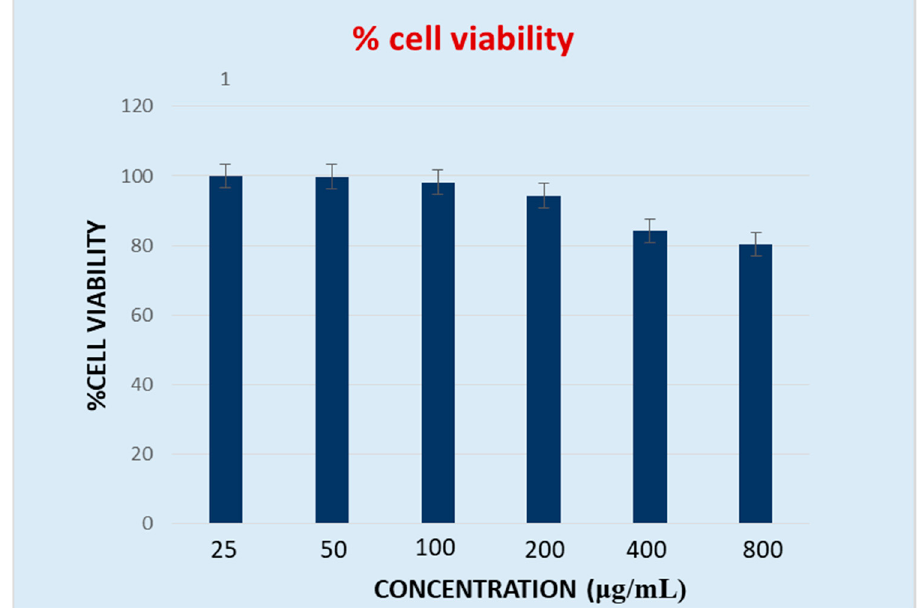
Figure 9. Effect of ethanol extract of C. papaya leaves on percentage viability of J774 cells.